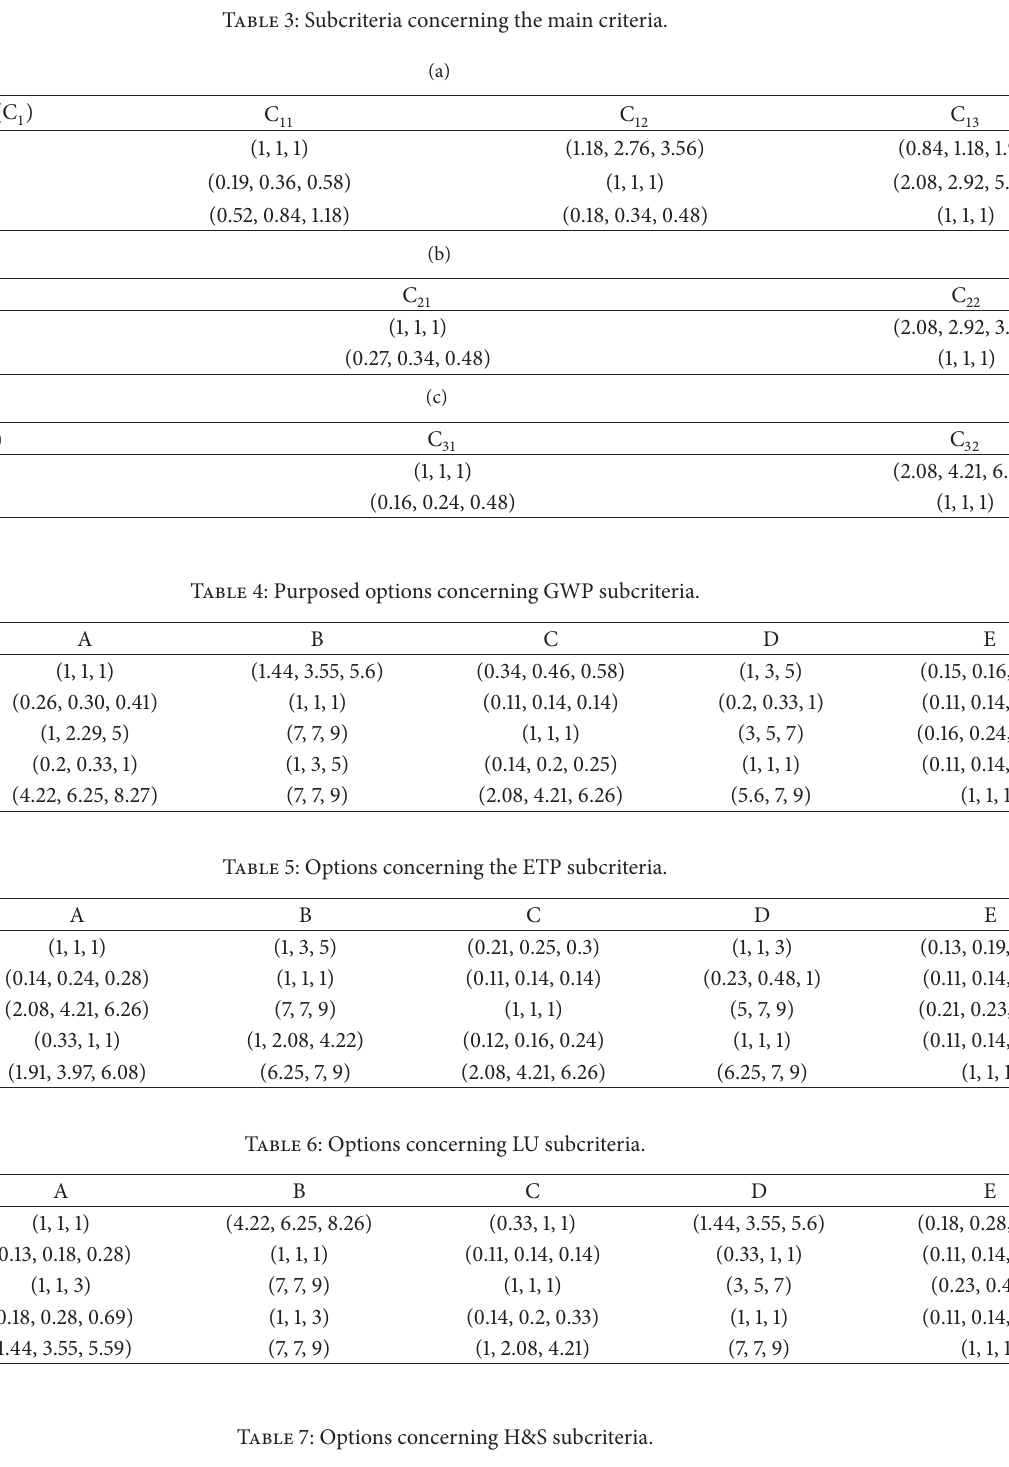
Table 3: Subcriteria concerning the main criteria.